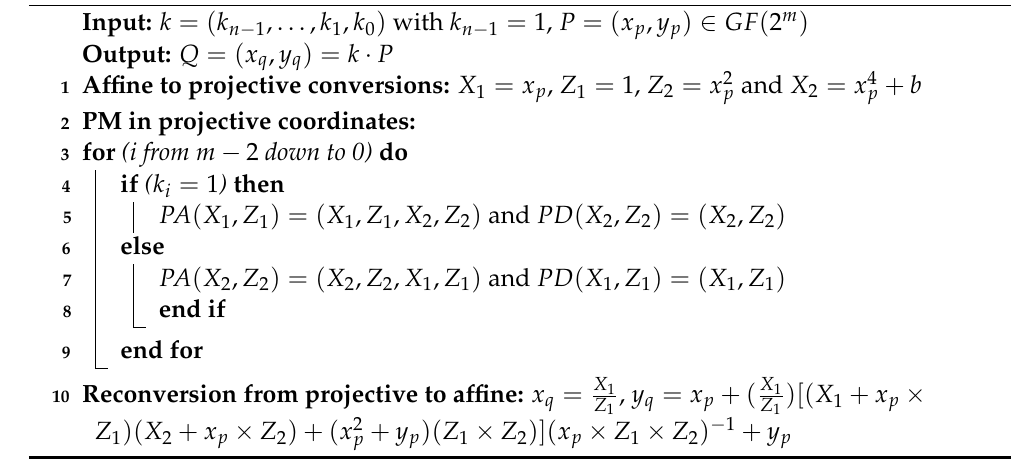
Algorithm 1: Montgomery PM Algorithm [17,26]